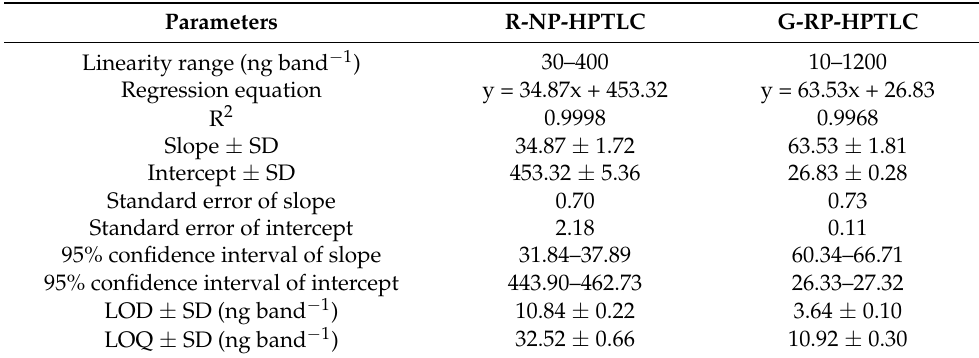
Table 1. Results for least square regression analysis of trans -resveratrol (TRV) for a routine normal- phase high-performance thin-layer chromatography (R-NP-HPTLC) and the ecologically greener reversed-phase HPTLC (G-RP-HPTLC) techniques (mean ± SD; n = 6).